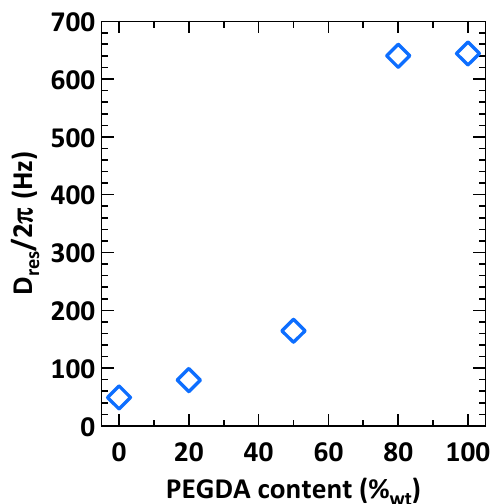
Figure 7. D res values obtained from 1 H DQ NMR measurements as listed in Table 3 plotted as a function of PEGDA content.